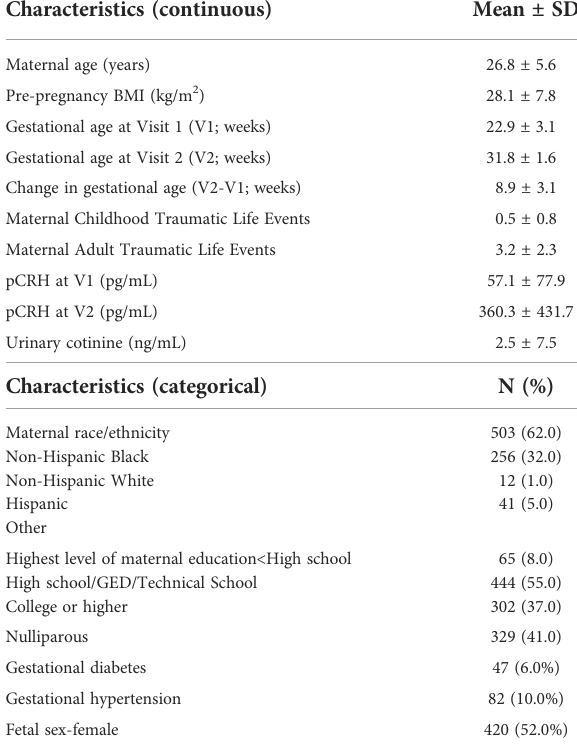
TABLE 1 Characteristics of CANDLE mother-child dyads